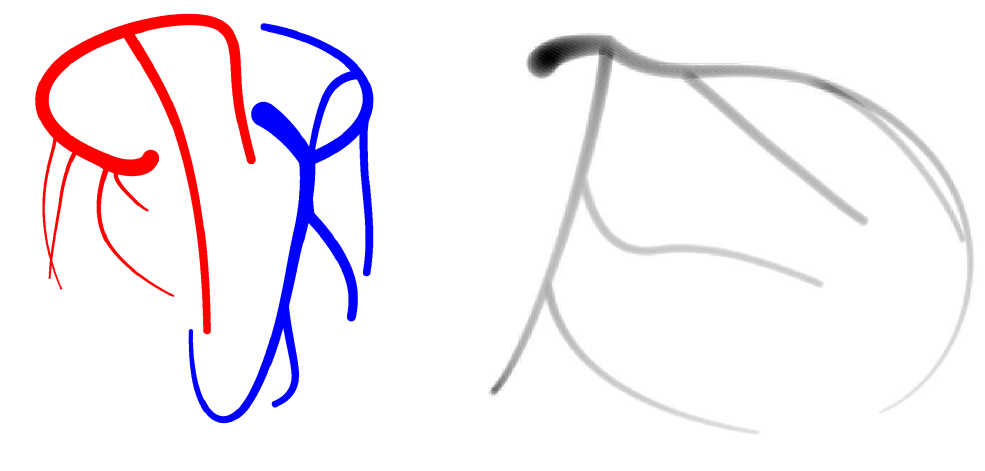
Figure 1. Digital phantom of the main vessels in the coronary arterial tree as respresented as a cloud of points ( left ), and an example of a derived, radiographically realistic projection ( right ). The left system is shown in blue and appears on the right side of the image; the right system is shown in red. This phantom represents the case in which no vessel presents